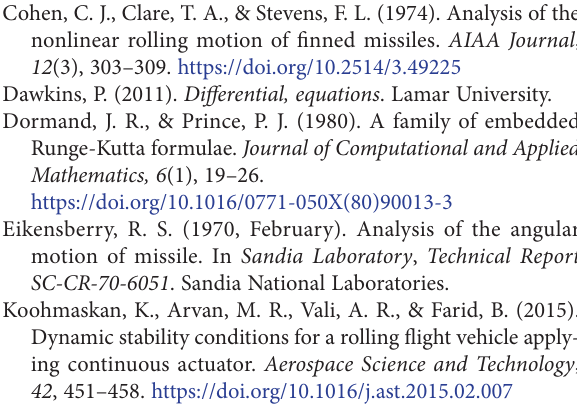
Figure 19. Comparison between closed form solution and linear 4-DOF model with ideal ON-OFF control